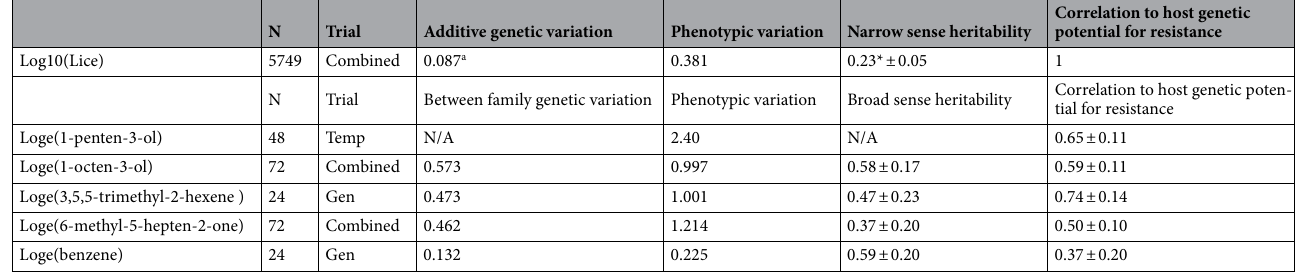
Table 3. Genetic parameter estimates of mucosal VOCs and their phenotypic correlation to salmon lice resistance estimated breeding values. *N = number of fish in analysis, N/A = not applicable, values after ± are standard errors.